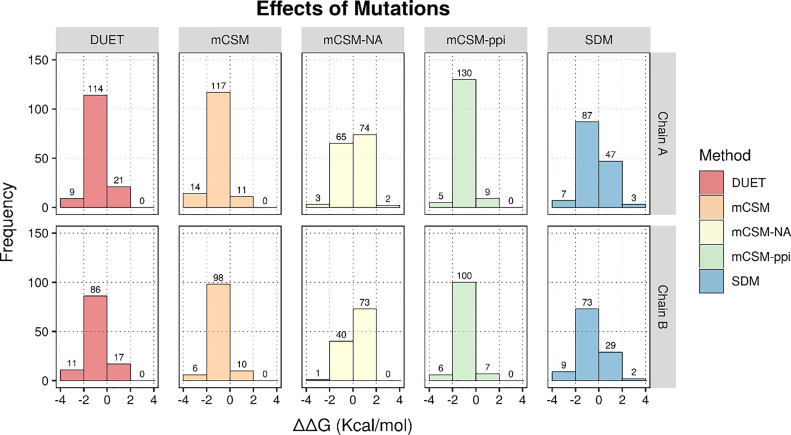
Frequency distribution graphs illustrating the distribution of experimentally known PDE6A and PDE6B mutations based on ΔΔG values predicted through DUET, mCSM-PS, mCSM-NA, mCSM-PPI and SDM. The graph bars shows stabilizing mutations (ΔΔG ≥ 0 kcal/mol), slightly damaging mutations (0 > ΔΔG ≥ −2.00 kcal/mol) and highly destabilizing mutations (ΔΔG < −2.00 kcal/mol).